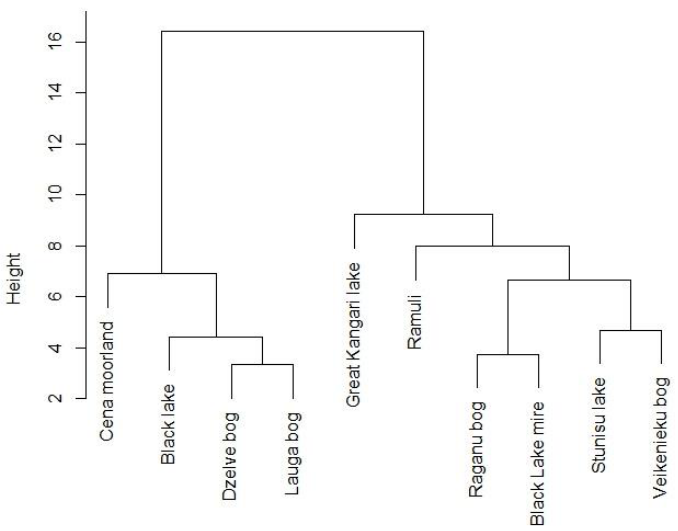
Figure 2. Dendrogram of hierarchical cluster analysis of cloudberry study sites based on vegetation composition. Levels of similarity between different sites are indicated by vertical linkage distance.